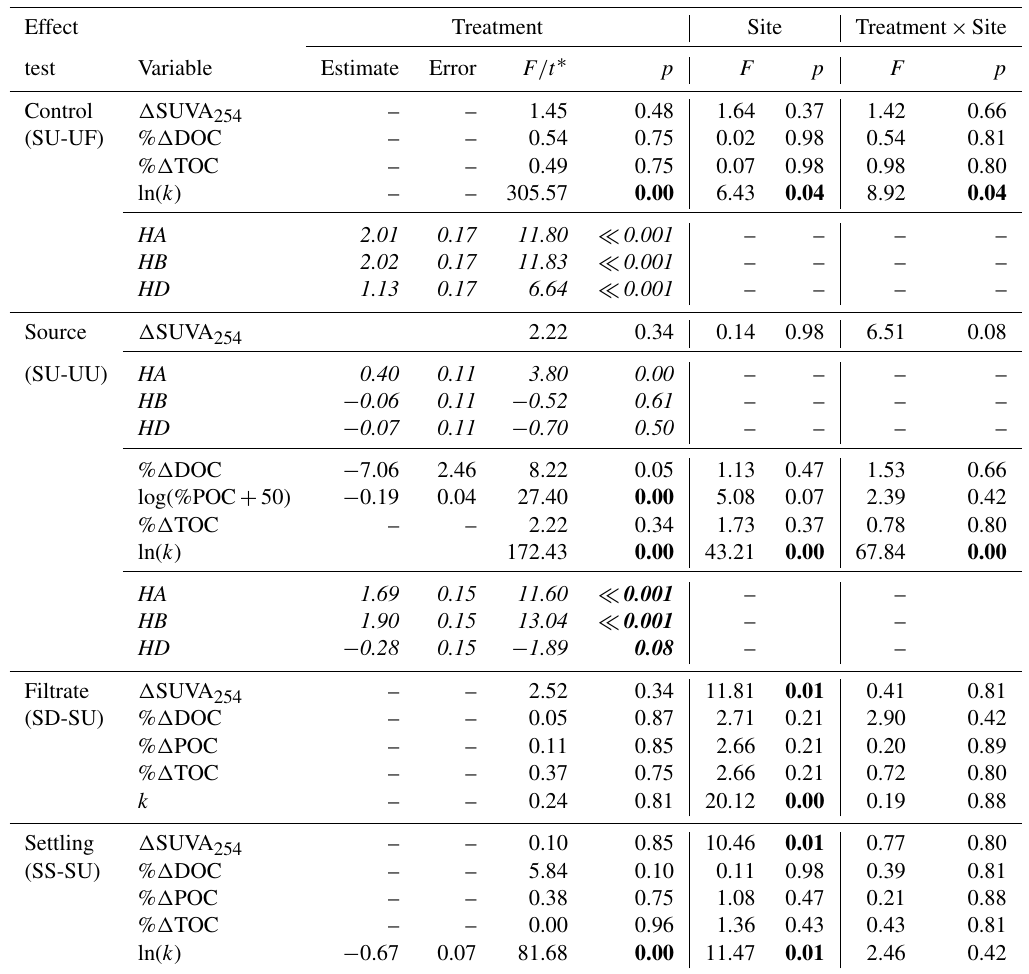
Table A1. Two-way ANOVAs of tests of sources, filtrate, and settling on biodegradability of POC in 2015 experiments. Follow-up Tukey- adjusted pairwise t tests are shown where significant interactions were present. Since SU treatments were tested three times and multiple outcomes were tested, p values reported in two-way ANOVAs were corrected for false discovery rate (19 tests). Degrees of freedom associ- ated with treatment, site, interaction, and residuals are 1, 2, 2, and 12 respectively for all tests. P values below 0.05 are in bold font. Italic font is used to differentiate follow-up Tukey-adjusted pairwise t tests from two-way ANOVA